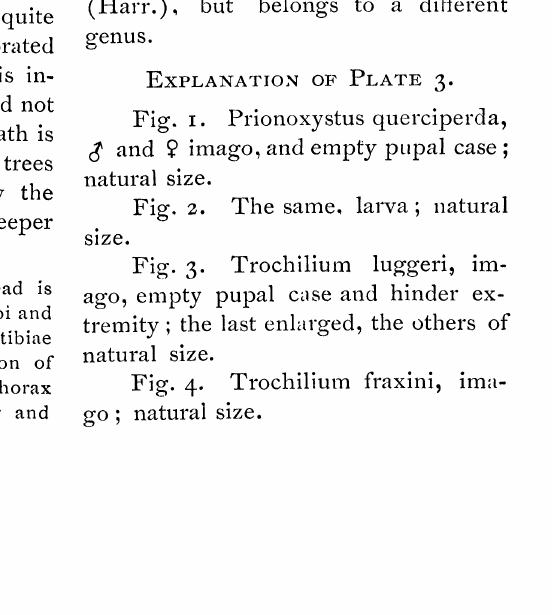
Fig. I. Prionoxystus querciperda, and empty pupal case o and 9 imago, natural size. Fig. z. The same, larva; natural size. Fig. 3" Trochilium luggeri, im- ago, empty pupal case and hinder ex- tremity the last enlarged, the others of natural size. Fig. 4" Trochilium fraxini, ima- go natural